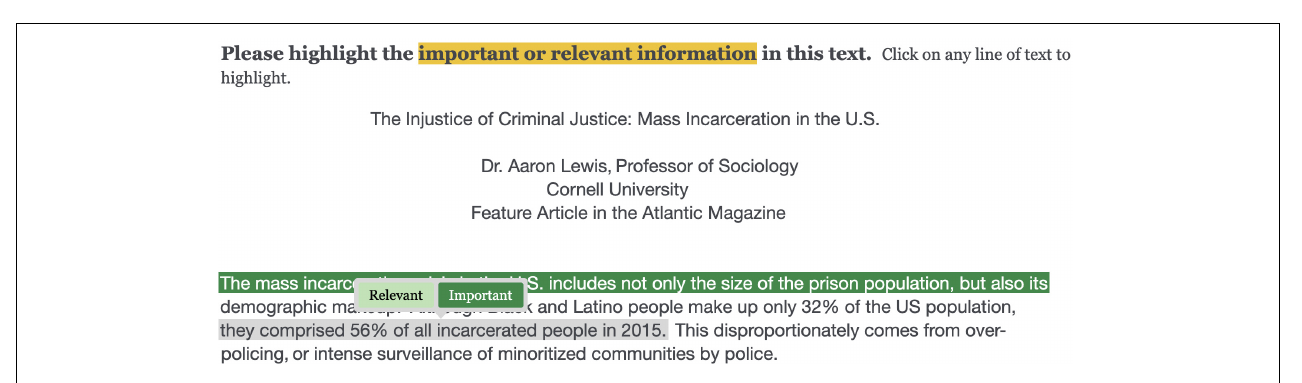
FIGURE 1 | Screenshot of highlighter tool for the intratextual strategy